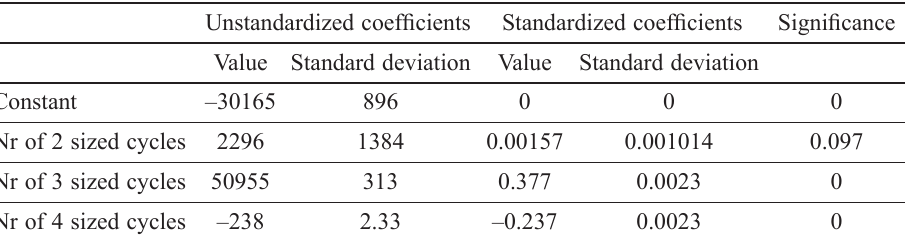
Table 3. Results of the linear regression with the value of the trade flow as a dependent